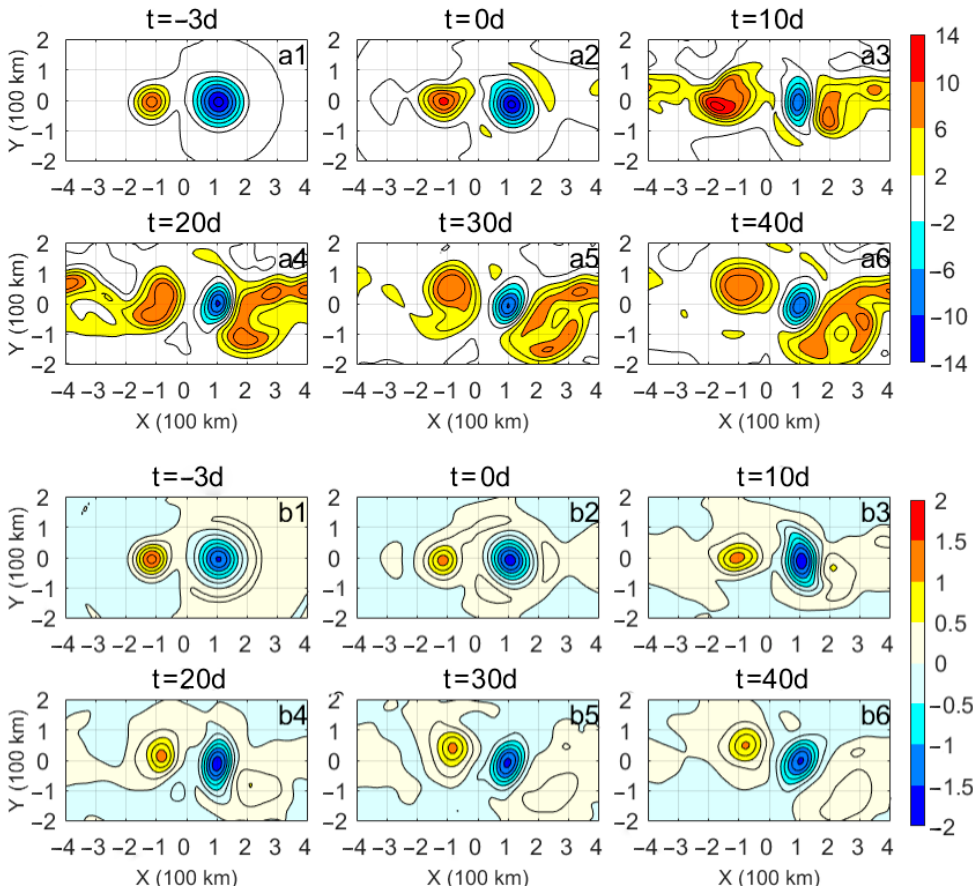
Figure 7. Temporal and spatial evolution in the dipole’s PVA (unit: 10 − 11 m − 1 · s − 1 ) on the σ = 26.0 and 26.5 isopycnal surfaces in the model: ( a1 – a6 ) are simulated PVA on the σ = 26.0 isopycnal surface located in the thermocline at − 3, 0, 10, 20, 30, and 40 days after the TC, respectively; ( b1 – b6 ) are simulated PVA on the σ = 26.5 isopycnal surface below the thermocline at − 3, 0, 10, 20, 30, and 40 days after the TC, respectively. The contour interval in ( a1 – a6 ) is 2 × 10 − 11 m − 1 · s − 1 , and that in ( b1 – b6 ) is 0.25 × 10 − 11 m − 1 ·s − 1 . All the subgraphs are the numerical results of 1°×1° lowpass spatial filtering.